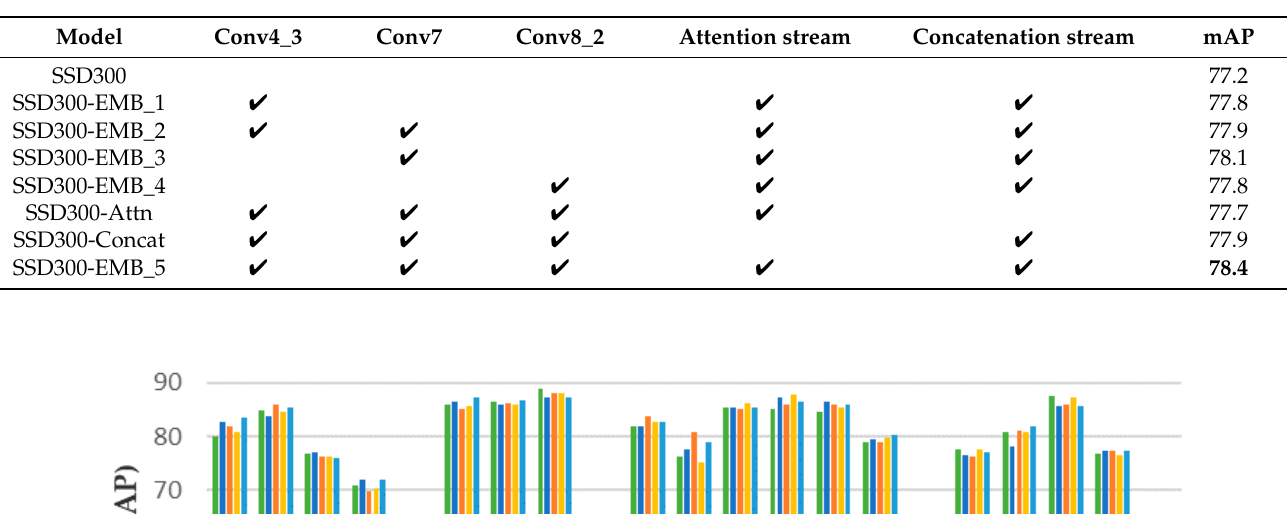
Table 5. Influences of EMB when applied on the PASCAL VOC 2007 test set. Bold indicates our model adopted by the ablation study.